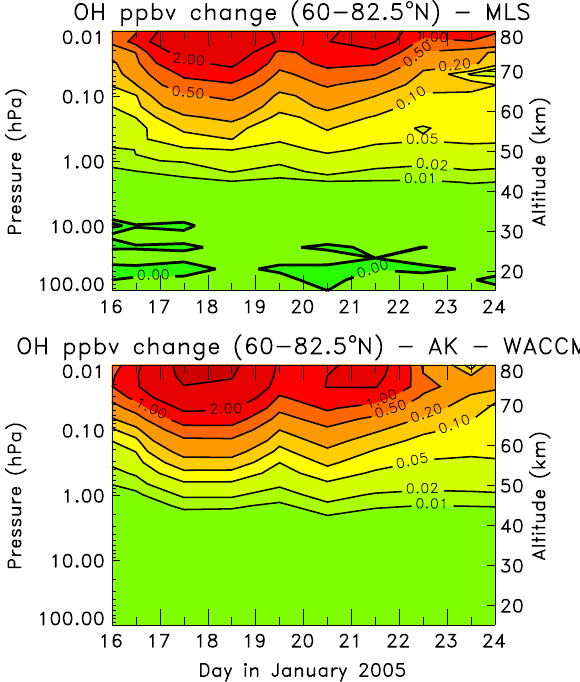
Fig. 5. Daily averaged OH changes from Aura MLS measurements (top) and WACCM3 B average predictions (bottom) for the 60– 82.5 ◦ N band. An average observed (predicted) OH profile for the period 1–14 January 2005 was subtracted from the observed (pre- dicted) OH values for the plotted days (16–23 January 2005). The contour intervals for the OH differences are 0.0, 0.01, 0.02, 0.05, 0.1, 0.2, 0.5, 1, 2, and 5ppbv. The MLS averaging kernel (AK) was used to sample the WACCM3